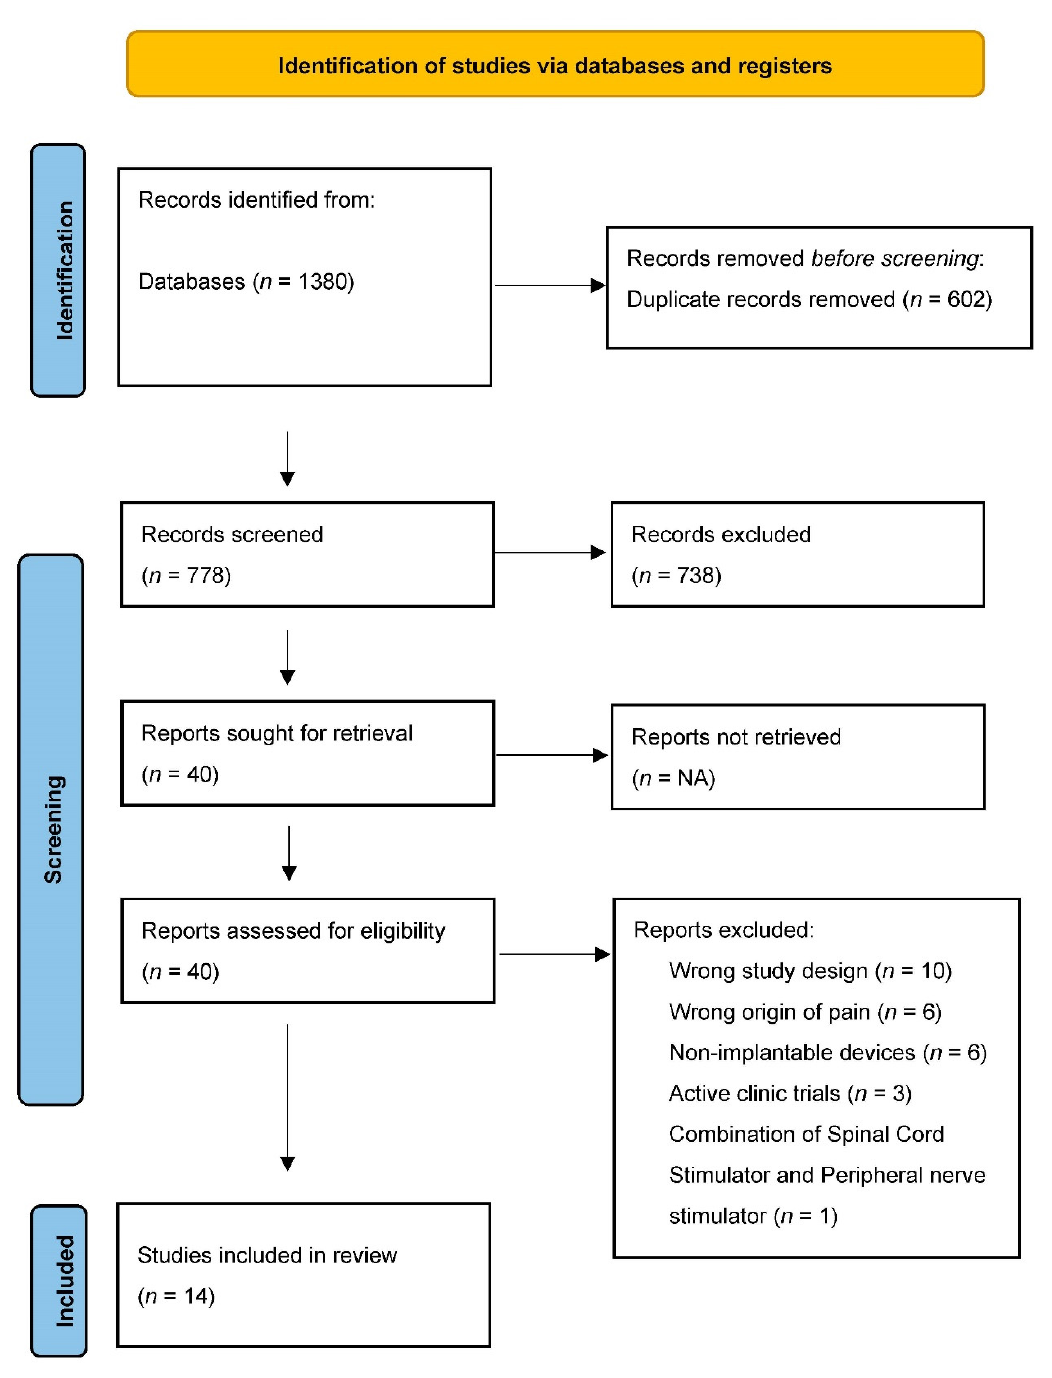
Figure 1. PRISMA Flow Chart. PRISMA flow diagram for systematic review. Flowchart of the study selection process, inclusion and exclusion of studies, and reasons for exclusion are displayed.